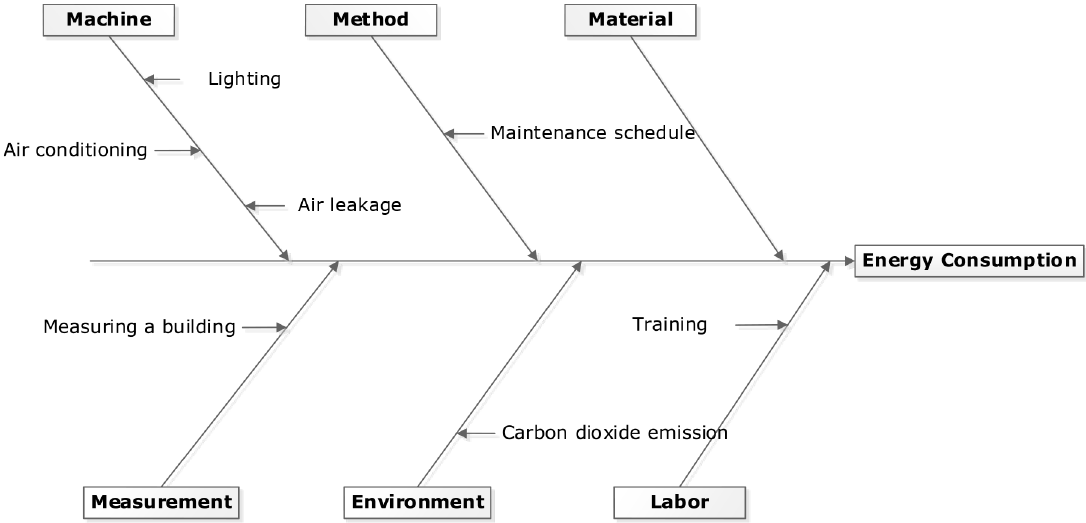
Figure 6. Ishikawa diagram for the reduction of energy consumption of Alpha